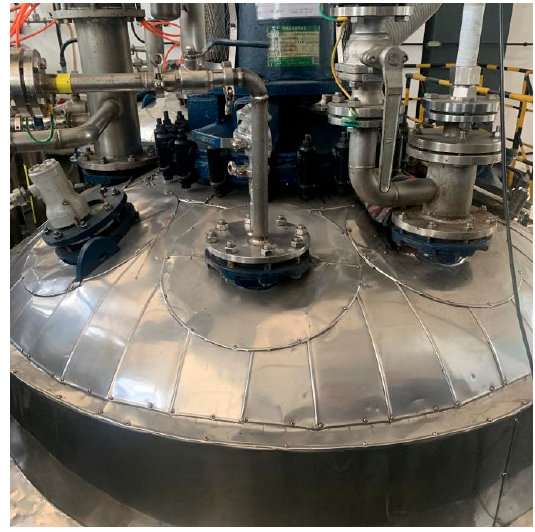
Figure 2. Site enterprise reaction ke tt le.